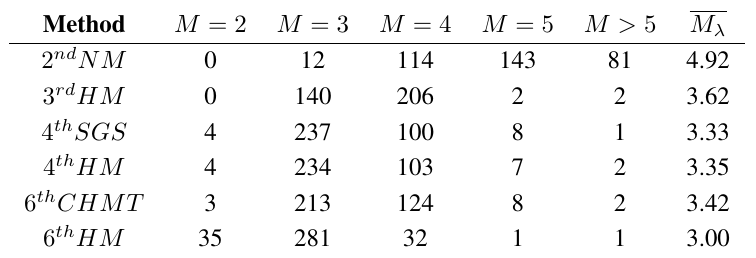
Table 3. Comparison of number of λ ’s in different methods for 1-D Bratu problem.